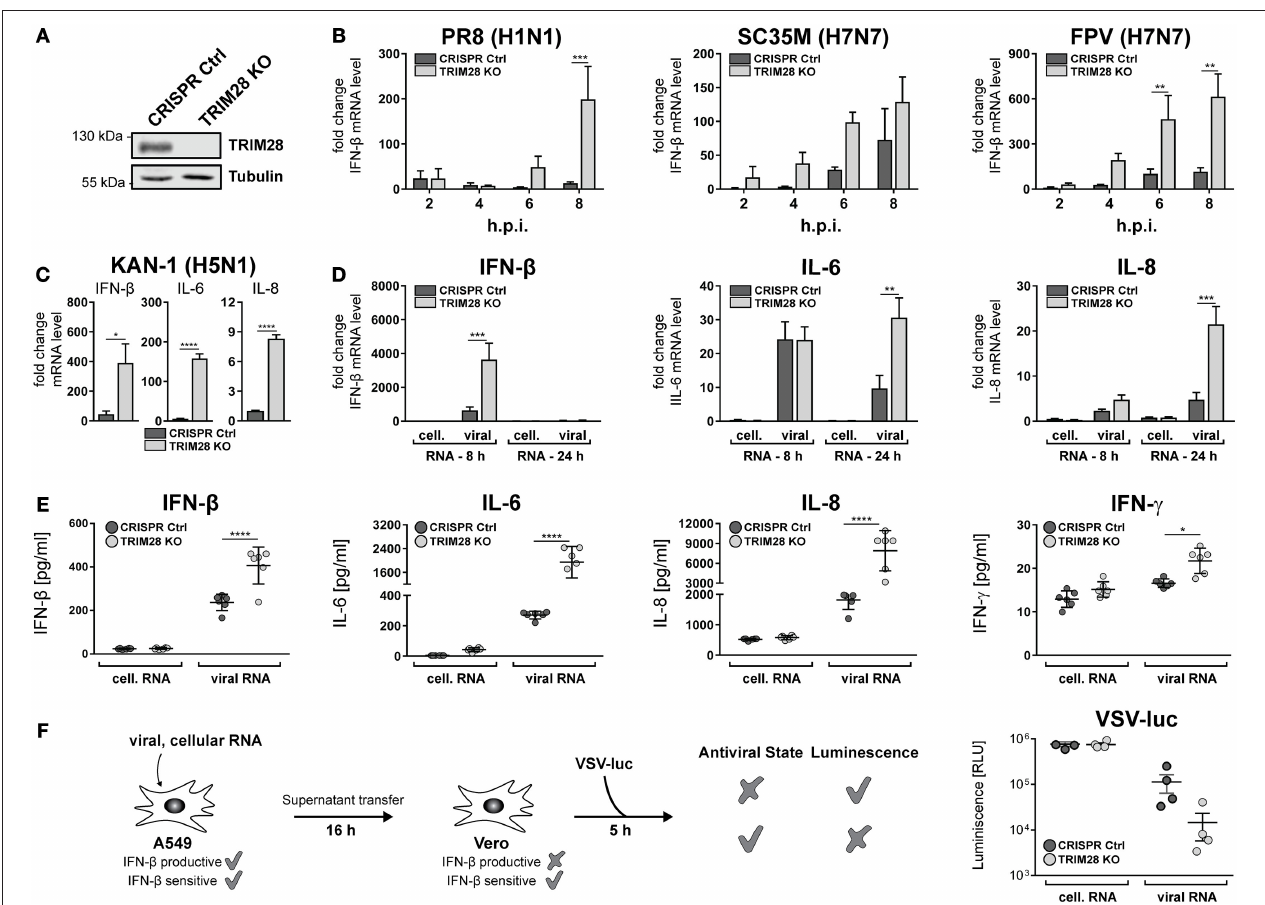
FIGURE 3 | TRIM28 is a negative regulator of the innate immune response during influenza A virus infection. (A) Western blot of A549 TRIM28 KO cells. (B) Infection of TRIM28 KO cells with PR8, SC35M and FPV at an MOI of 5. Total RNA was isolated at the indicated time points and IFN- β mRNA levels were analyzed by qRT-PCR. IFN- β levels are depicted as mean n -fold change ( ± SEM) compared to non-infected cells. ** p ≤ 0.002; *** p ≤ 0.0002; two-way ANOVA; Sidak’s multiple comparisons test. (C) TRIM28 KO cells were infected with KAN-1 (H5N1) at an MOI of 0.01 for 24h. IFN- β , IL-6 and IL-8 mRNA levels were determined as described in (B) . * p ≤ 0.03; **** p ≤ 0.0001; two-tailed unpaired t -test. (D) TRIM28 KO cells were transfected with 200 ng viral or cellular RNA. Total RNA was isolated 24h p.t. and IFN- β , IL-6 and IL-8 mRNA levels were determined by qRT-PCR. Results are shown as mean n -fold change ( ± SEM) over non-treated cells. ** p ≤ 0.0021; *** p